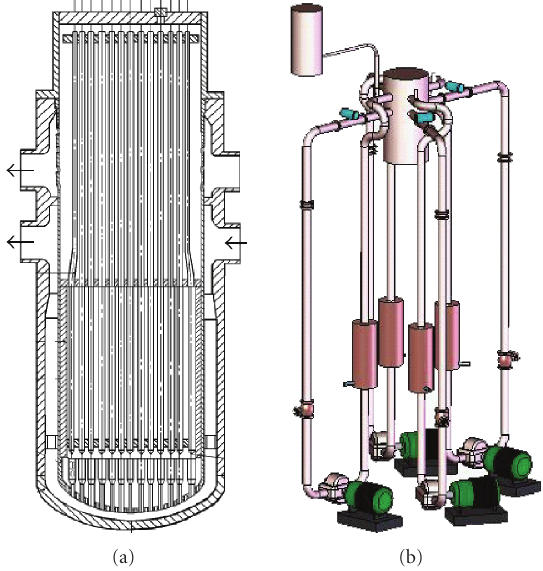
Figure 1: (a) Vertical cross-section of the RPV model; (b) 3D isometric sketch of the